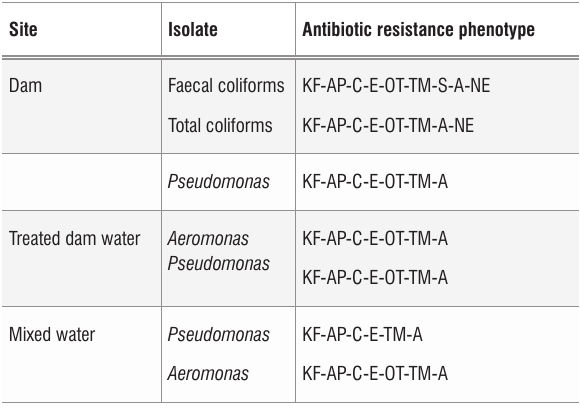
Prevalent antibiotic resistance phenotype of